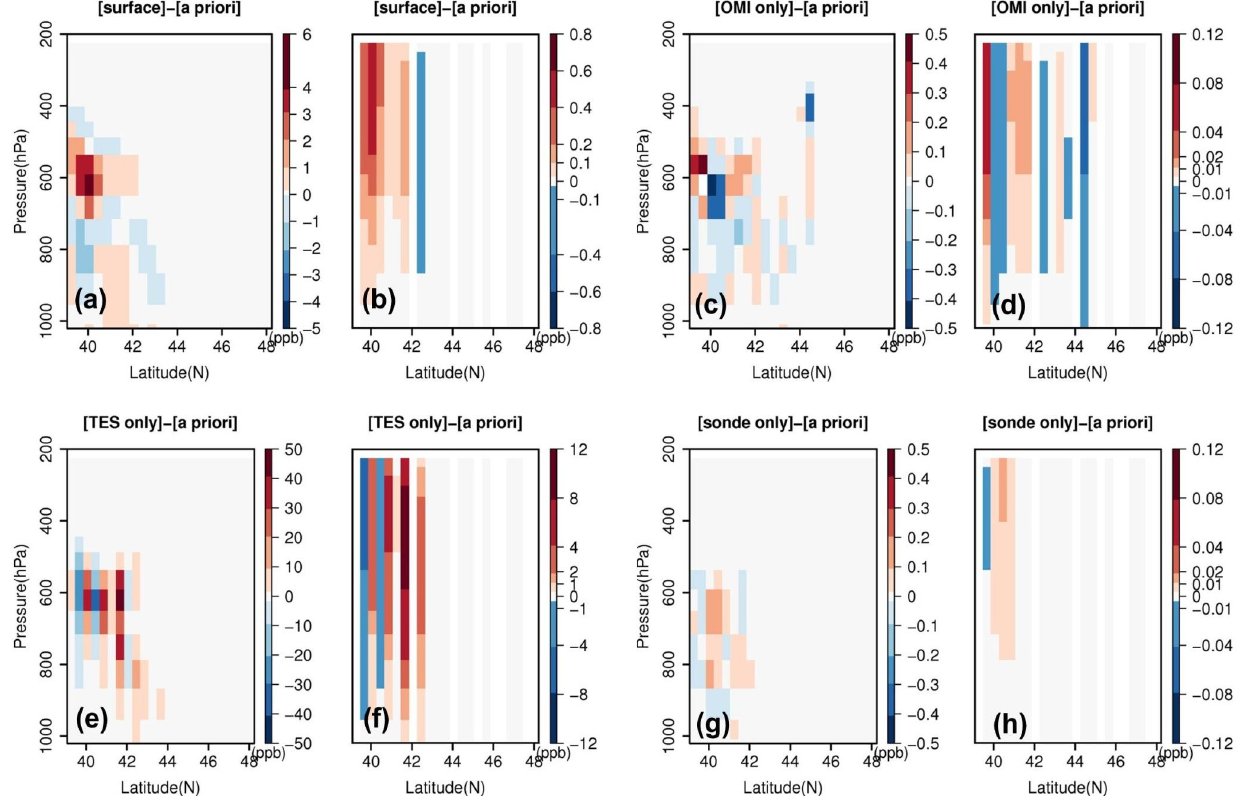
Fig. 14. Impacts of DA in the vertical. O 3 differences at the selected TES sampling locations: (a–b) Case AS-STEM a priori; (c–d) Case AO-STEM a priori; (e–f) Case AT-STEM a priori; (g–h) Case AD-STEM a priori. (a,c,e,g) compare the raw data in TES pressure grids and (b,d,f,h) compare the results after applying the TES observation